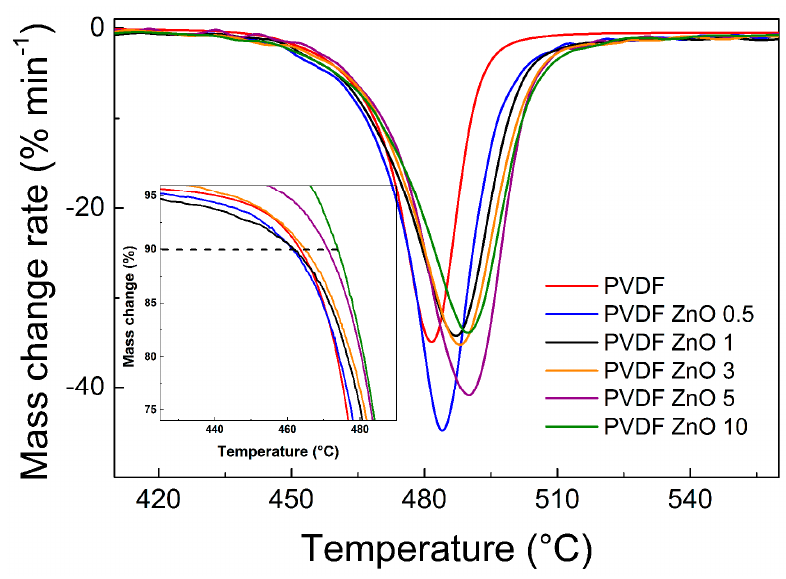
Figure 7. Thermogravimetric spectra in its derivation form for neat PVDF and the PVDF ZnO star-like composite films with various filler contents. Inset figure is highlighted the T 10% evaluation. Table 3. Summarized values of the TGA curves investigation for neat PVDF and PVDF ZnO star-like composite films with various filler contents.